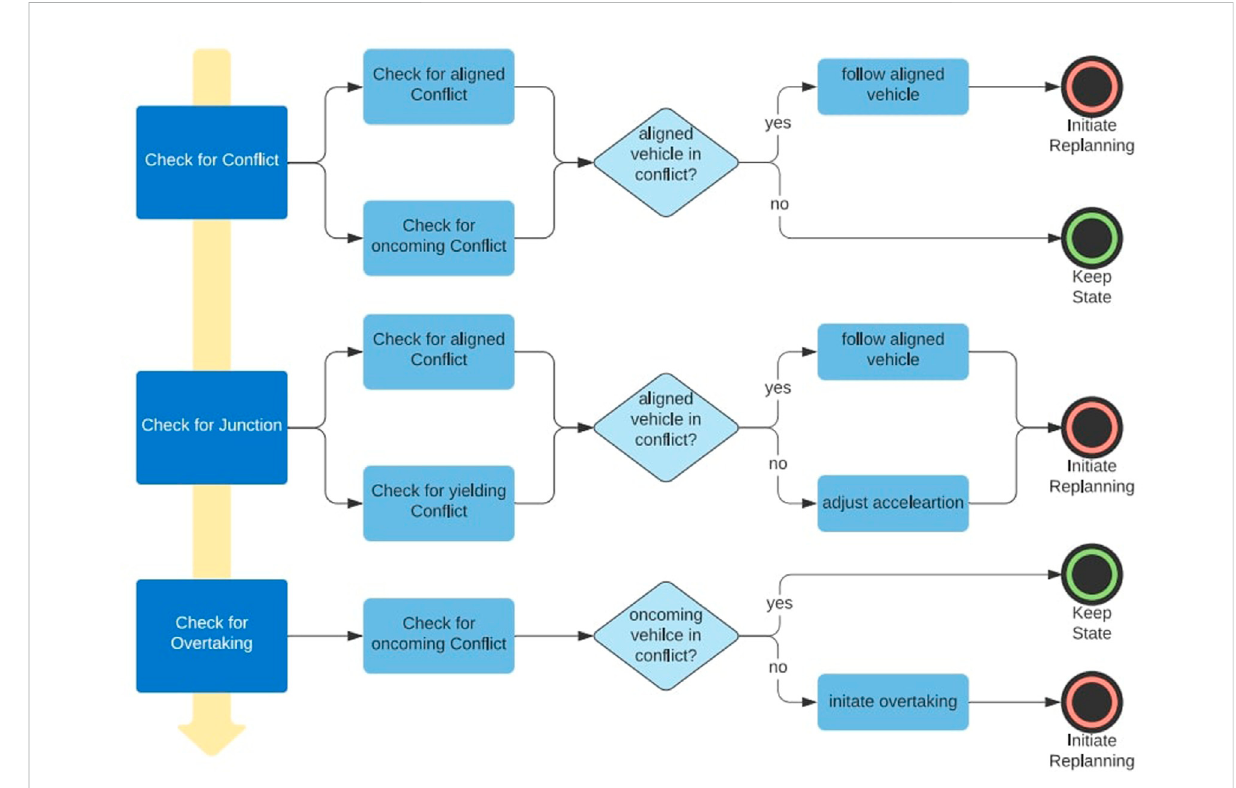
FIGURE 6 The developed Controlling Unit logic of the autonomous